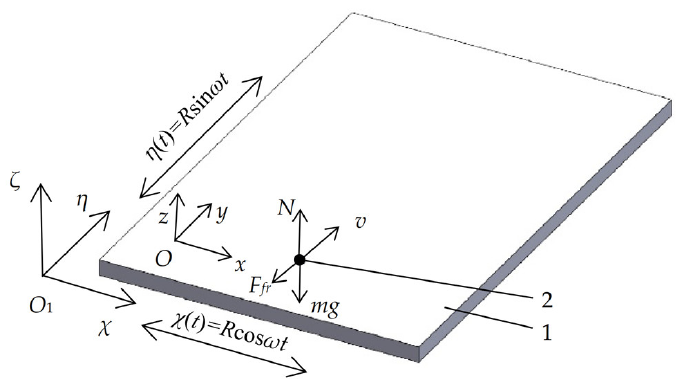
Figure 1. Scheme of the dynamic model of omnidirectional manipulation of particles on a platform subjected to circular motion: (1) platform; (2) particle.